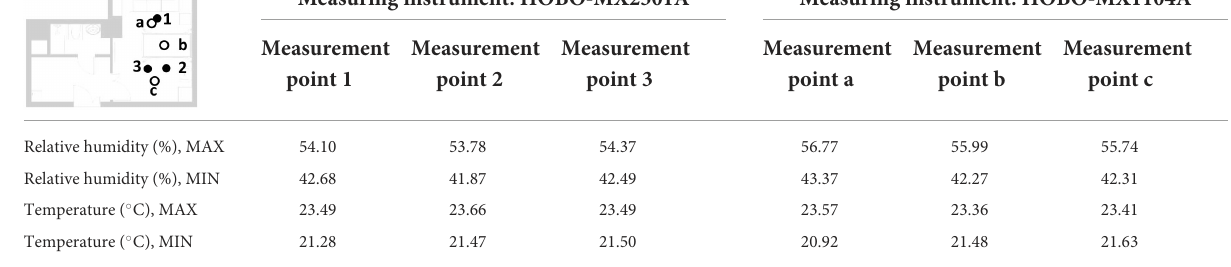
TABLE 3 Measured results of thermal environment elements.